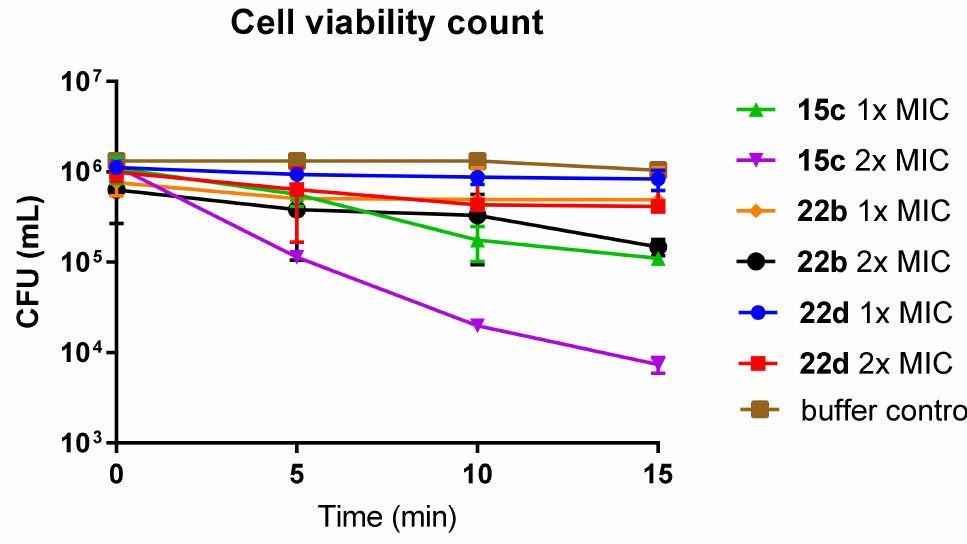
Figure 6. Cell viability count of S. aureus in the presence of compound 15c, 22b and 22d at 1 × and 2 × their